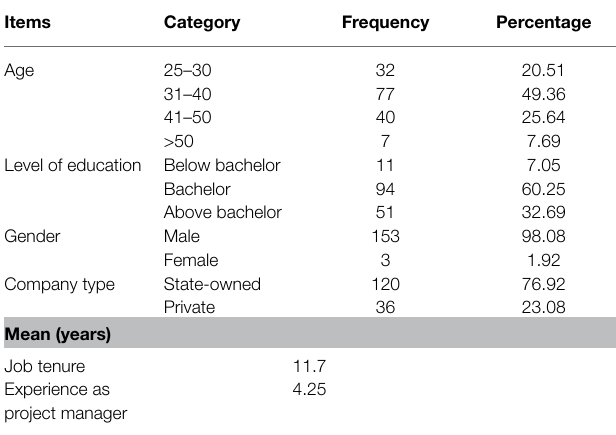
TABLE 1 | Sample demographics of participated project